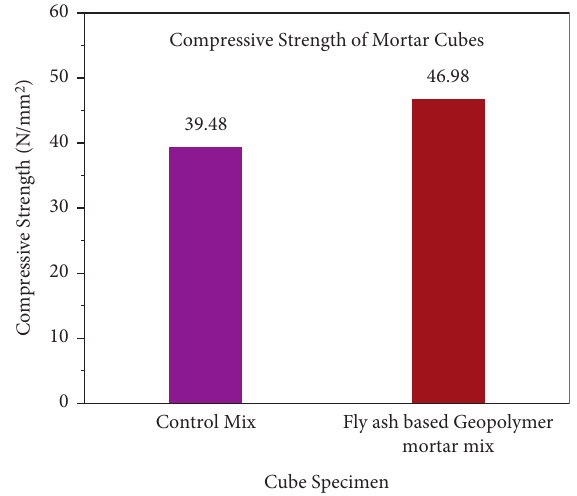
Figure 11: Compressive strength of the geopolymer